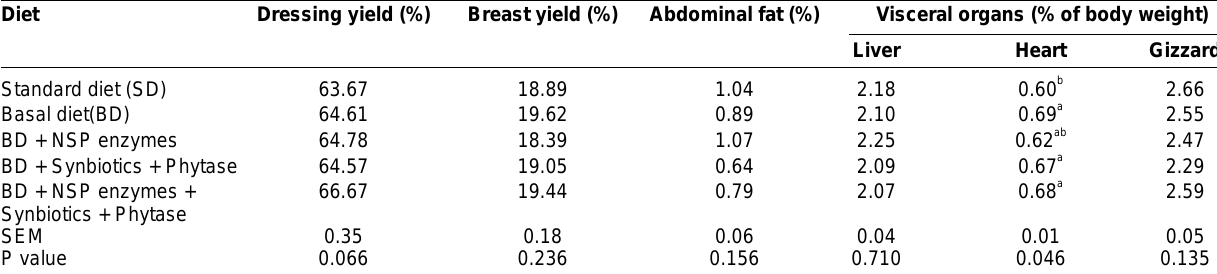
Table-7. Effect on slaughter characteristics of broilers fed low calorie diet supplemented with NSP enzymes, synbiotics and phytase